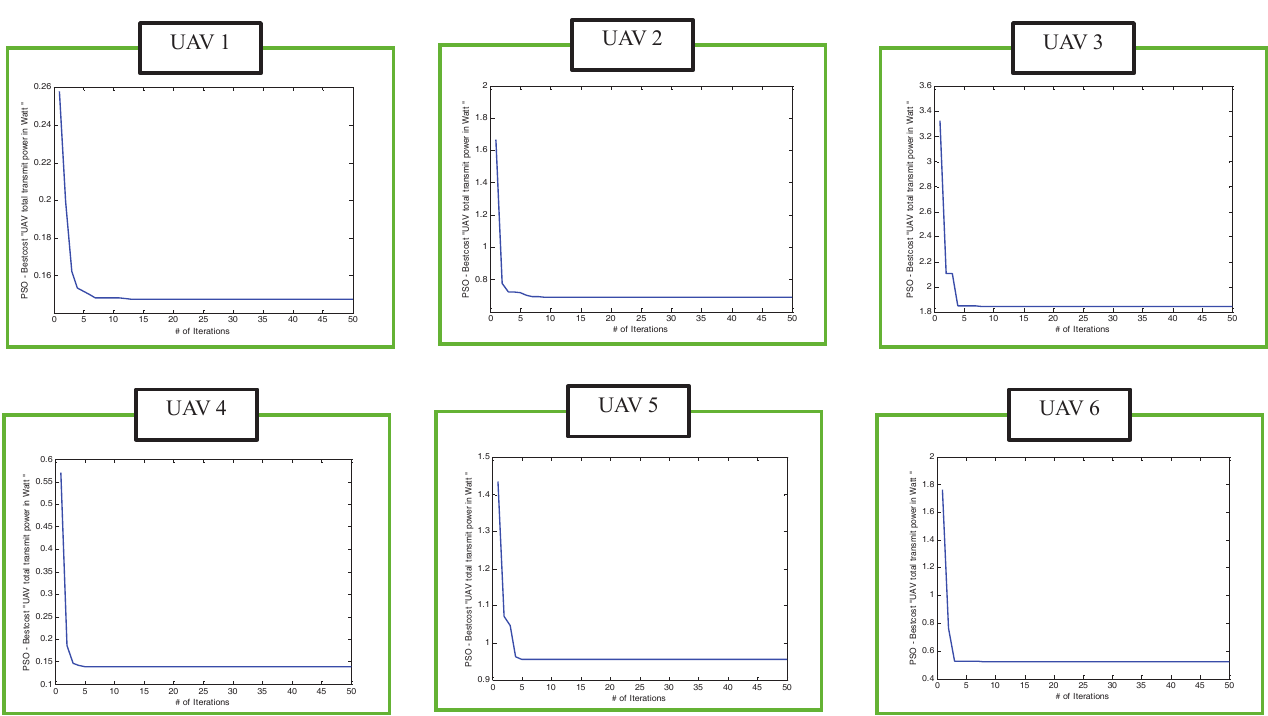
Figure 10. The convergence speeds of the power-efficient algorithm that iteratively invoked PSO- based clustering and PSO-based efficient algorithms for UAV1 to UAV6 when users were non- uniformly distributed.